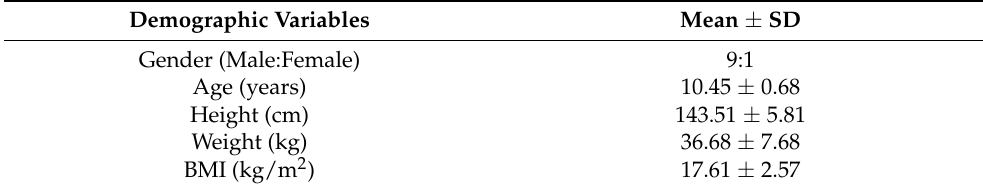
Table 1. Participants’ Demographic